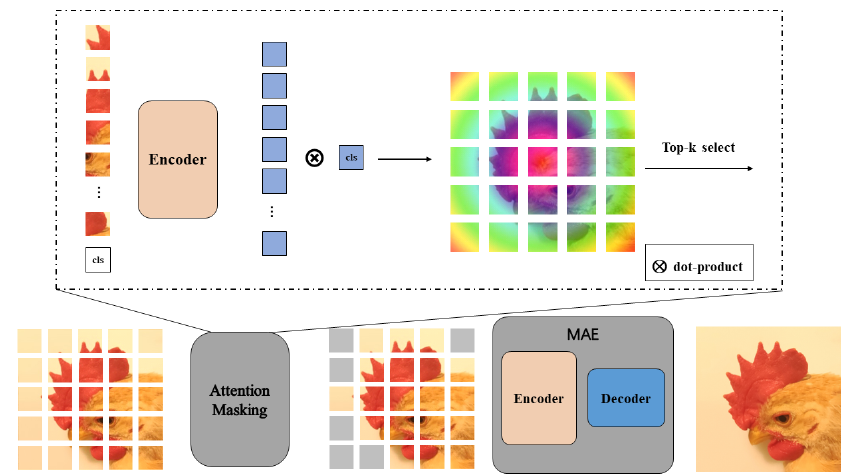
Figure 4. Illustration of our